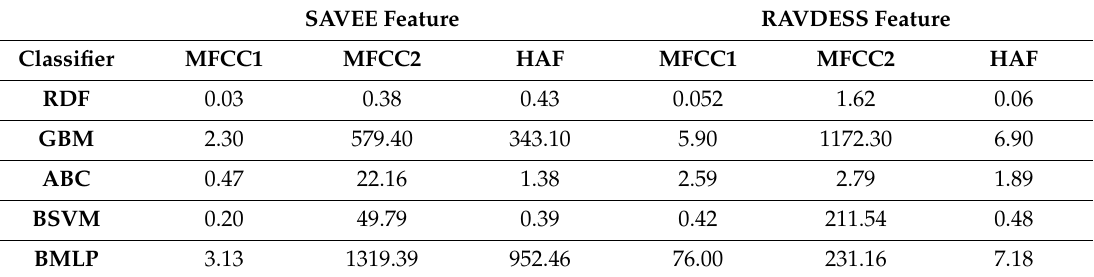
Table 3. Processing time of learning algorithms trained with Mel-frequency cepstral coe ffi cient